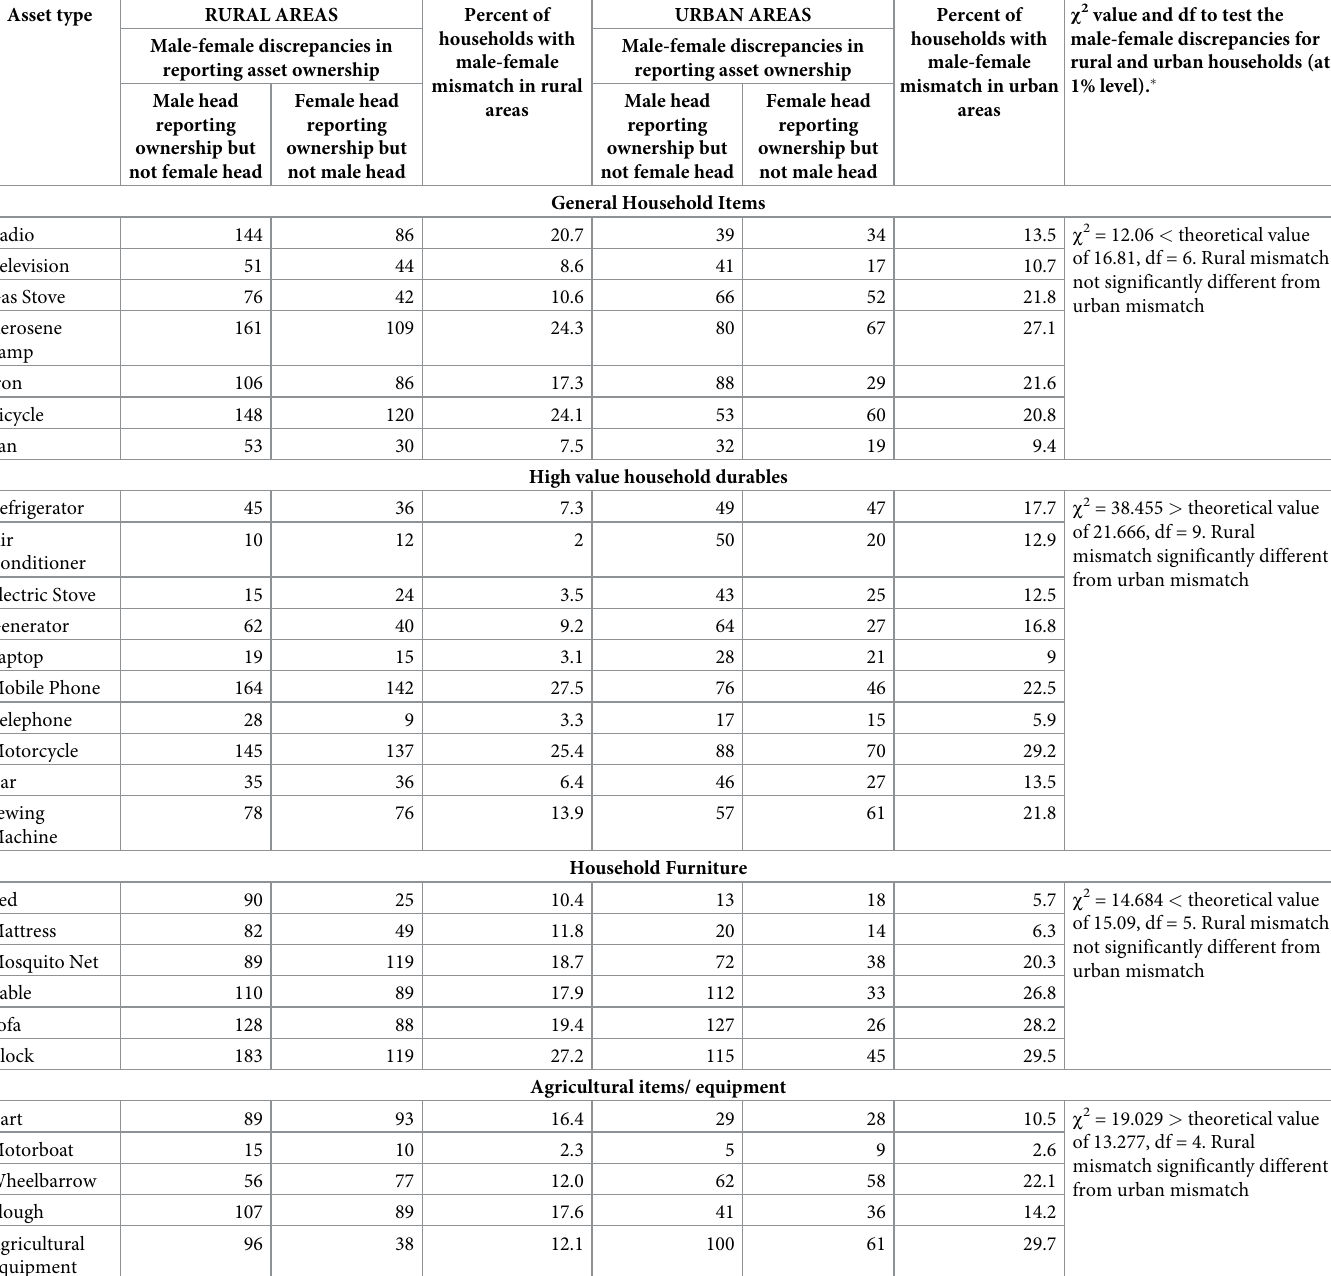
Table 3. Reported ownership of different assets by male and female heads of households in Urban and Rural areas, Northern